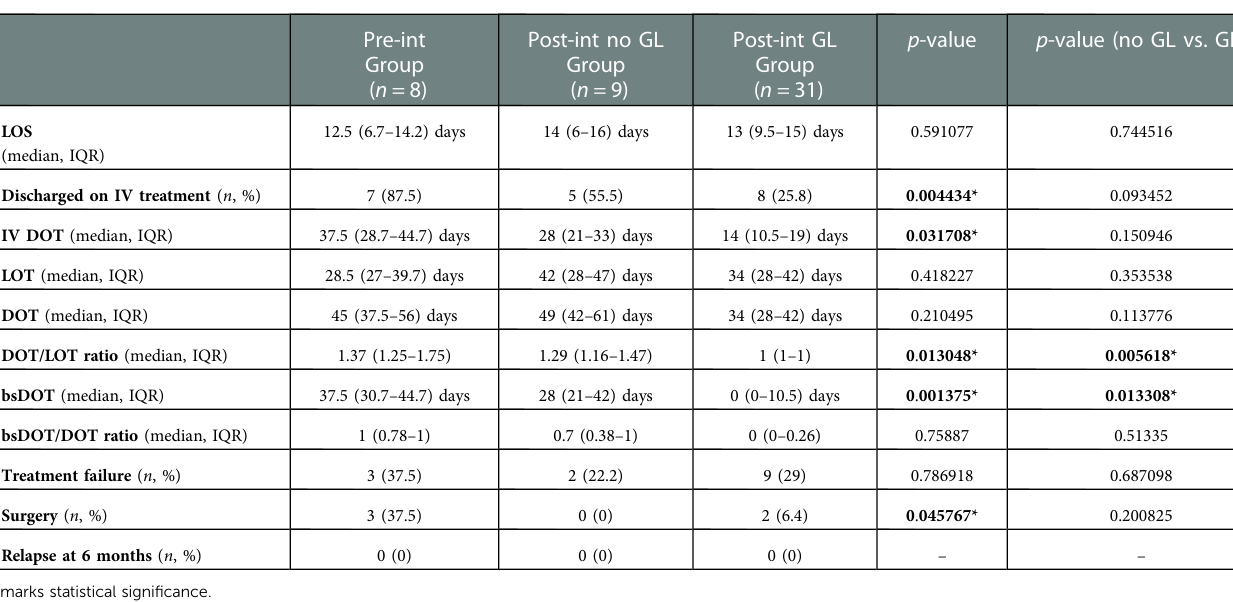
TABLE 4 Outcomes - OM.